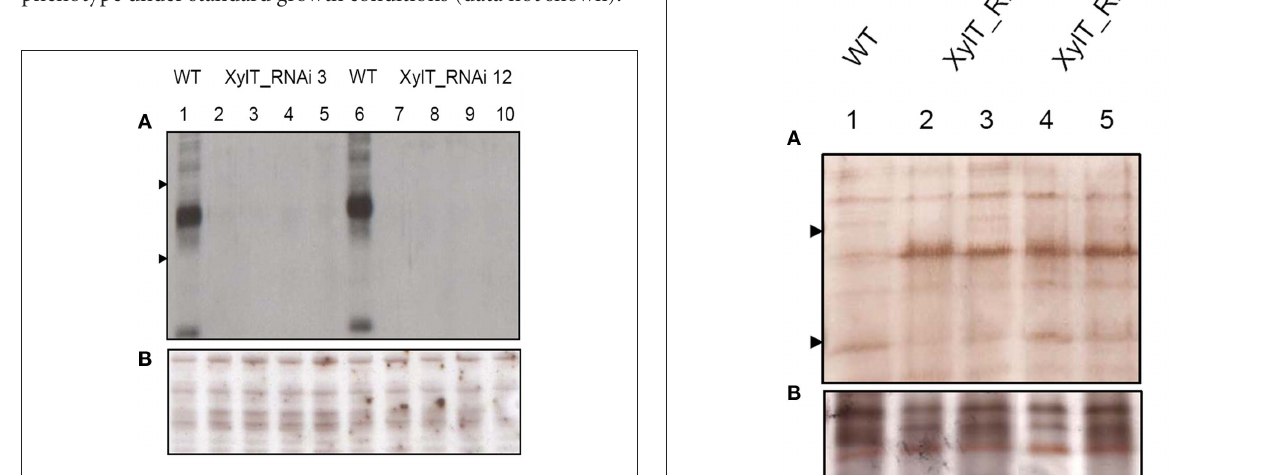
FiguRe 2 | Detection of xylose-containing N- glycans in protein extracts from transgenic XylT_RNAi and wild type tomato fruits. (A) Immunoblot analysis of β 1,2-xylose-containing N -glycans of WT (lane 1 and 6) and independent T2 plants of XylT_RNAi line 3 (lanes 2–5) and XylT_RNAi line 12 (lanes 7–10), the β 1,2-xylose-containing N -glycans were visualized using anti- β -1,2-xylose-specific antibodies. Protein standards of 55 and 36 kDa are represented by arrow heads. (B) SDS-PAGE and silver staining of protein extracts from green fruits.